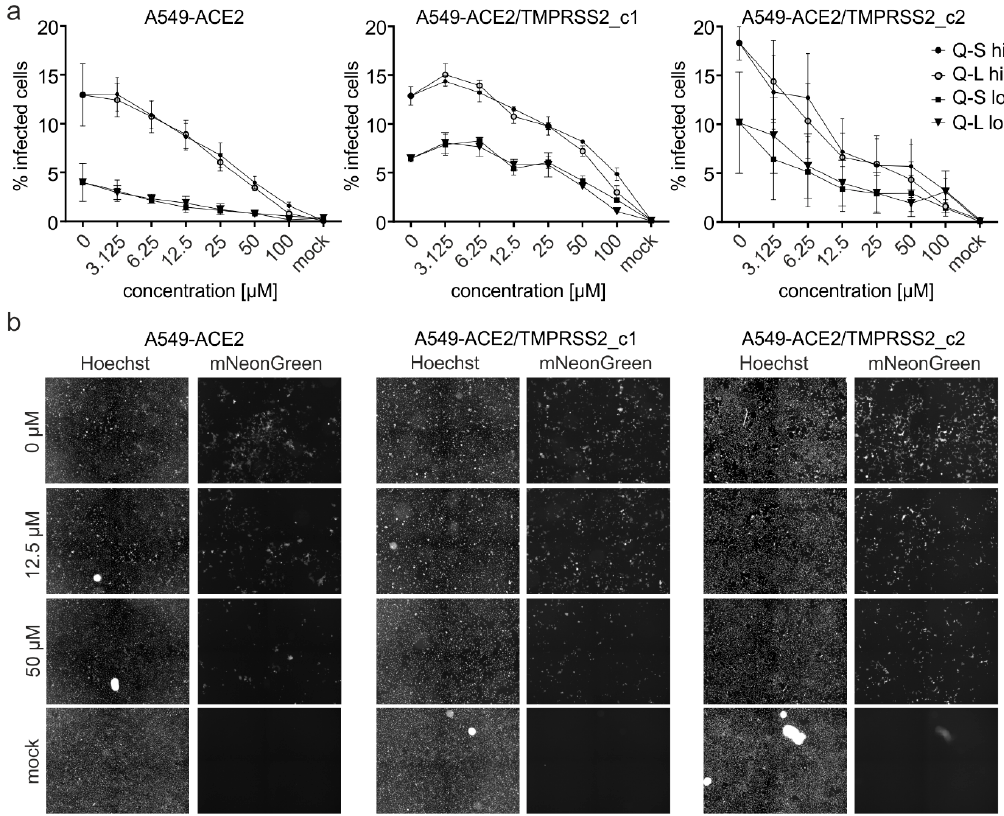
Figure 6. Influence of Q-S, Q-L on SARS-CoV-2-mNG infection in ACE2 and TMPRSS2-expressing A549 cells. A549-stably transduced to express ACE2, ACE2/TMPRSS2 clone 1, and ACE2/TMPRSS2 clone 2 were infected with SARS-CoV-2-mNG at high and low MOIs (see M&M) for 1 h or mock-infected. Then the inoculum was removed, and the cells were treated with the indicated amounts of Q-S and Q-L. At 48 hpi, cells were fixed with 2% PFA and nuclei were stained with 1 µg/mL Hoechst. ( a ) The total amount of cells (Hoechst+) and infected cells (mNeonGreen+) were analyzed by automated microscopy to calculate the absolute % of infected cells. Mean values and SEM are calculated from three independent experiments. ( b ) Representative fluorescence microscopy images (4-fold magnification) of high titer infection of the respective cell line treated with the indicated amounts of Q-L.